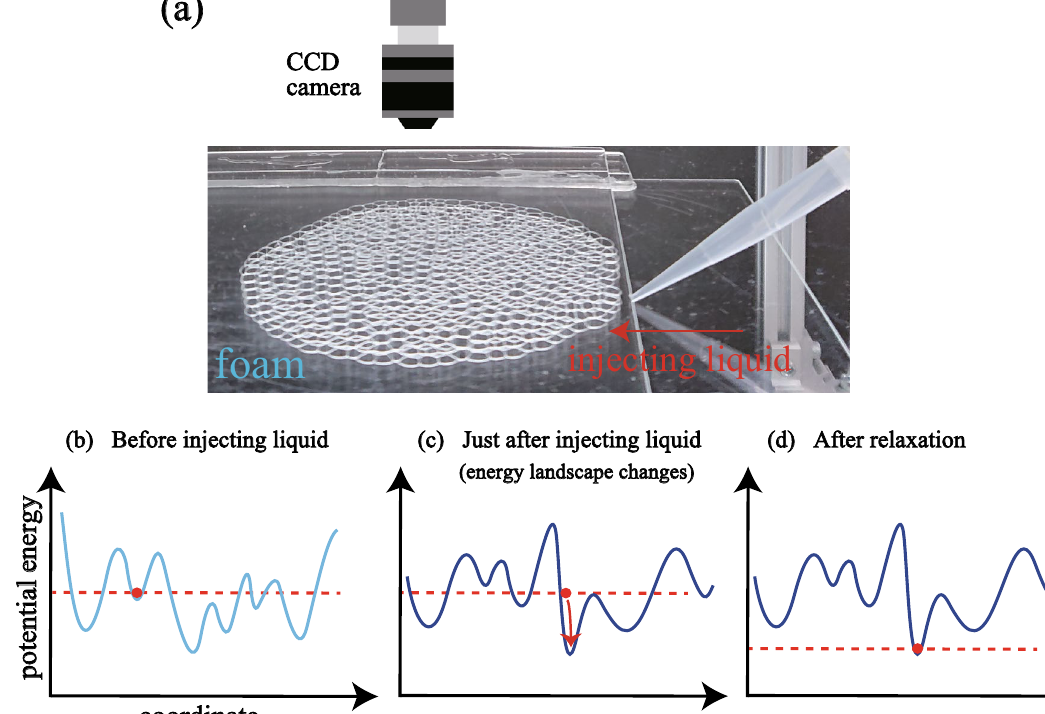
Figure 1. ( a ) Schematic of the experimental setup. We slowly inject a fixed amount of liquid (500 µ l) into a foam sandwiched between two glass plates from the outside using a micropipette. We then observe the relaxation from the top of the foam using a CCD camera. ( b – d ) Schematic of the energy landscape and the relaxation process. ( b ) Before injection, the foam is located in an energy basin. ( c ) Just after injection, the energy landscape changes since the number of possible states for the bubbles increases with increasing liquid fraction. We experimentally observe how the state relaxes into a new basin as shown in ( d